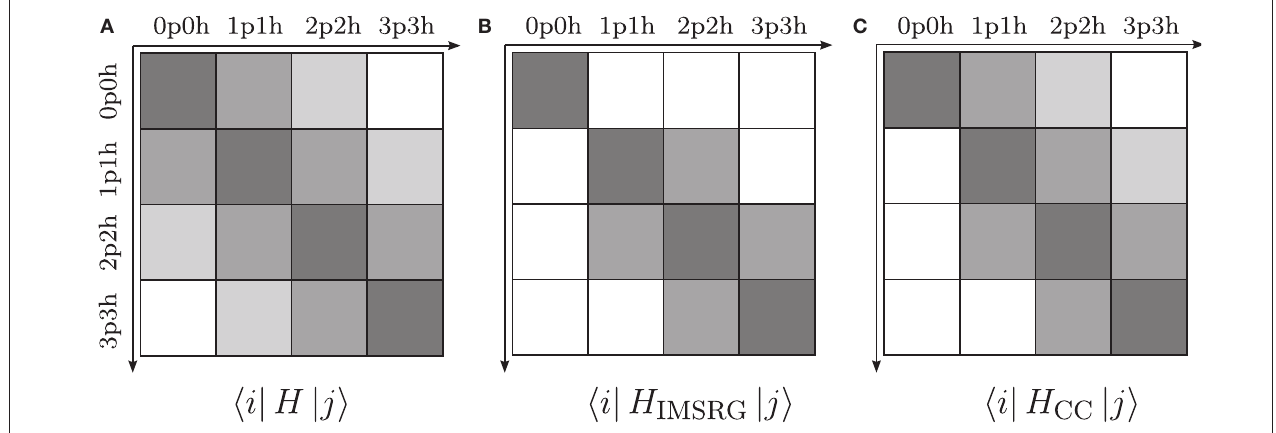
FIGURE 3 | Decoupling of particle-hole excitations from a 0p0h reference state: the schematic matrix representation of the initial Hamiltonian H 0 (A) and the transformed Hamiltonians obtained from IMSRG (B) and CC (C) , respectively (see text for details).